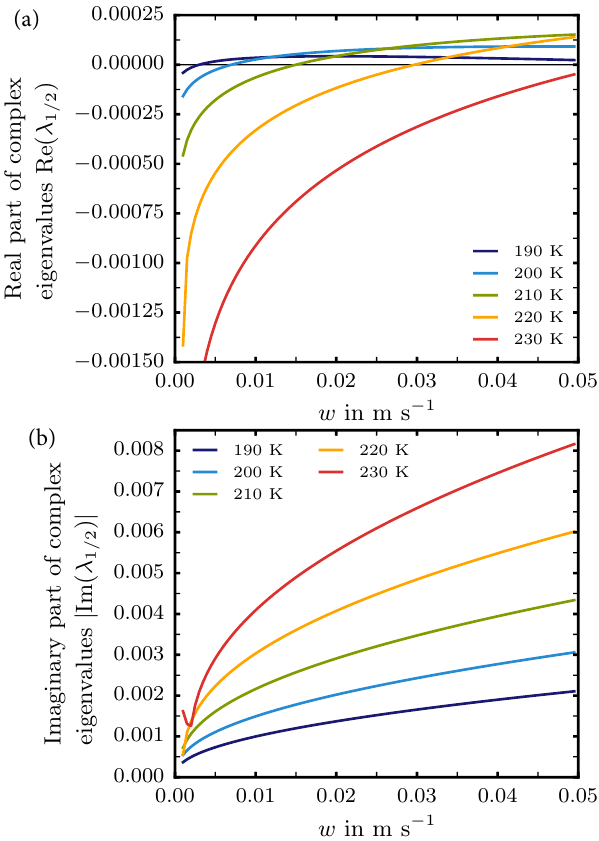
Figure 3. Real (upper panel) and imaginary part (lower panel) of the complex eigenvalues λ 1 , 2 of the Jacobian DF | x point x 0 .